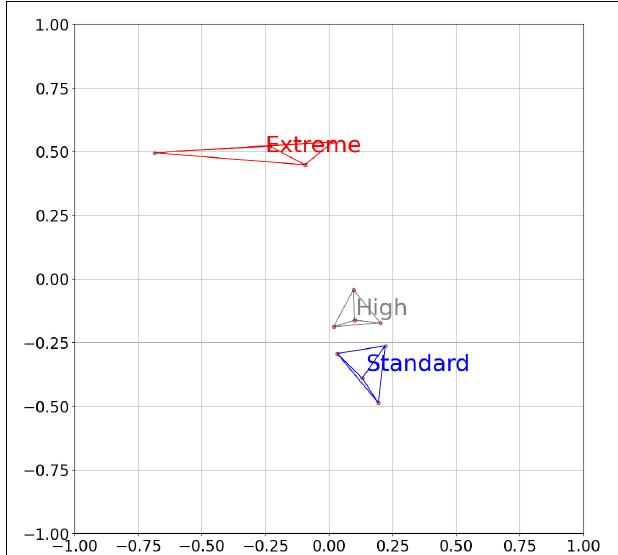
FIGURE 2 | An MDS plot of the individual cows based on the abundance of the predicted CAZy families (91 different families) across all bins of the rumen metagenome samples. The colored clusters represent the members of the three different diet groups. The separation score between the Standard and the Extreme is 2.15. The axes are arbitrary values, resulting from the reduction of the multidimensional space of correlation similarities into two dimensions.